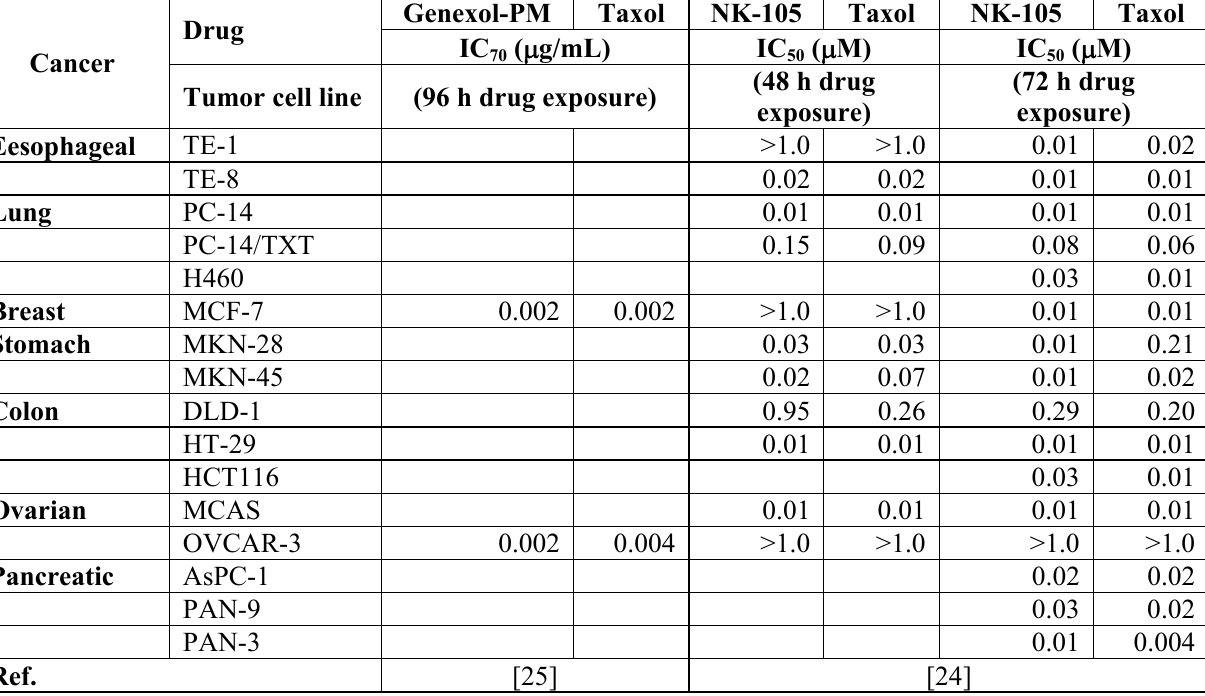
Table 3. In vitro evaluations of polymeric-paclitaxel micelles and Taxol in various cancer cell lines. Drug Cancer